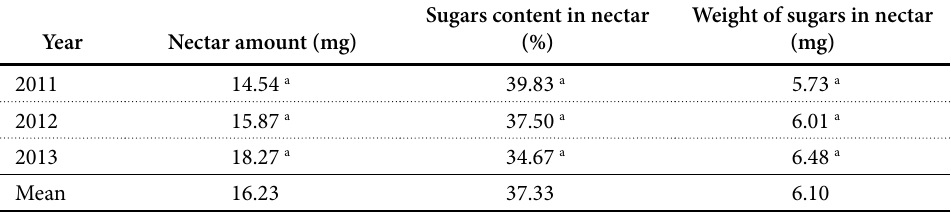
Tab. 2 Amount of nectar, sugar content of nectar, and total sugar mass in nectar per 10 flowers of Acer pseudoplatanus in 2011–2013.